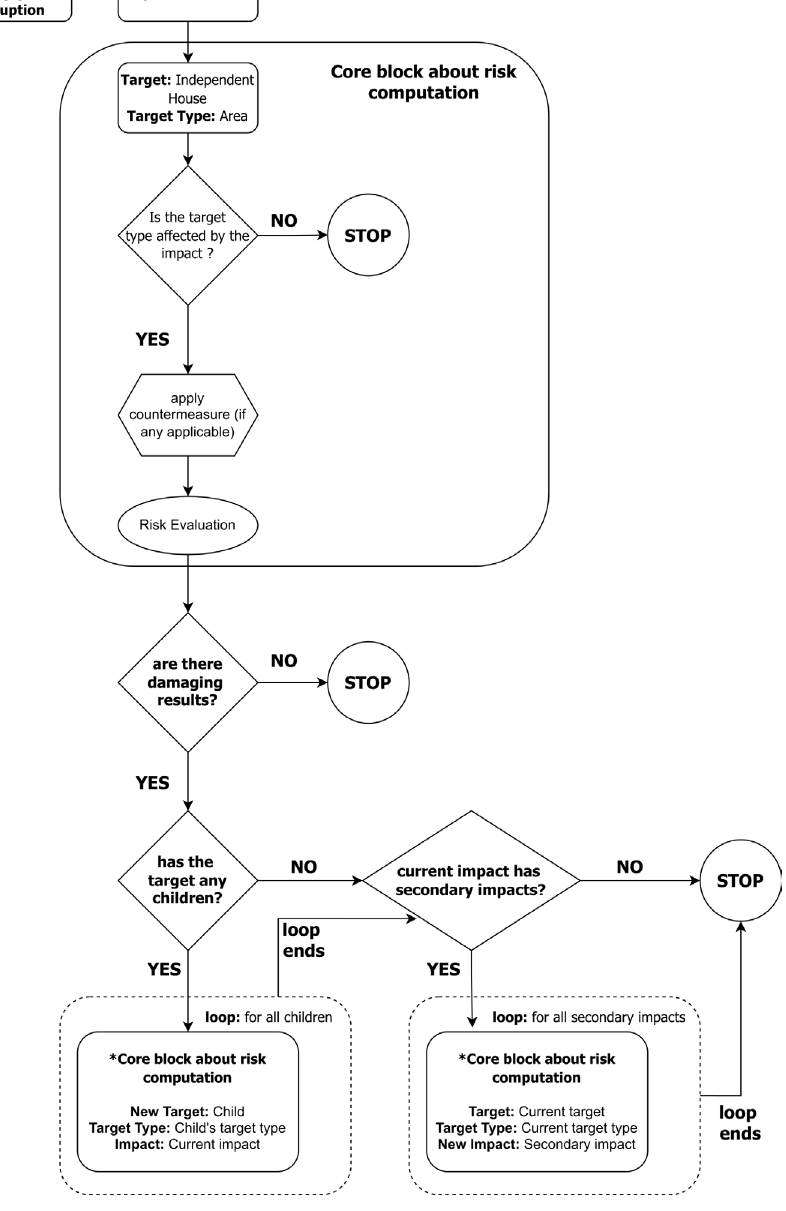
Figure 6. Flow chart of the algorithm logic based on the Power loss threat. The countermeasures influence the threat probability as a reduction coefficient. The corresponding assessment is based